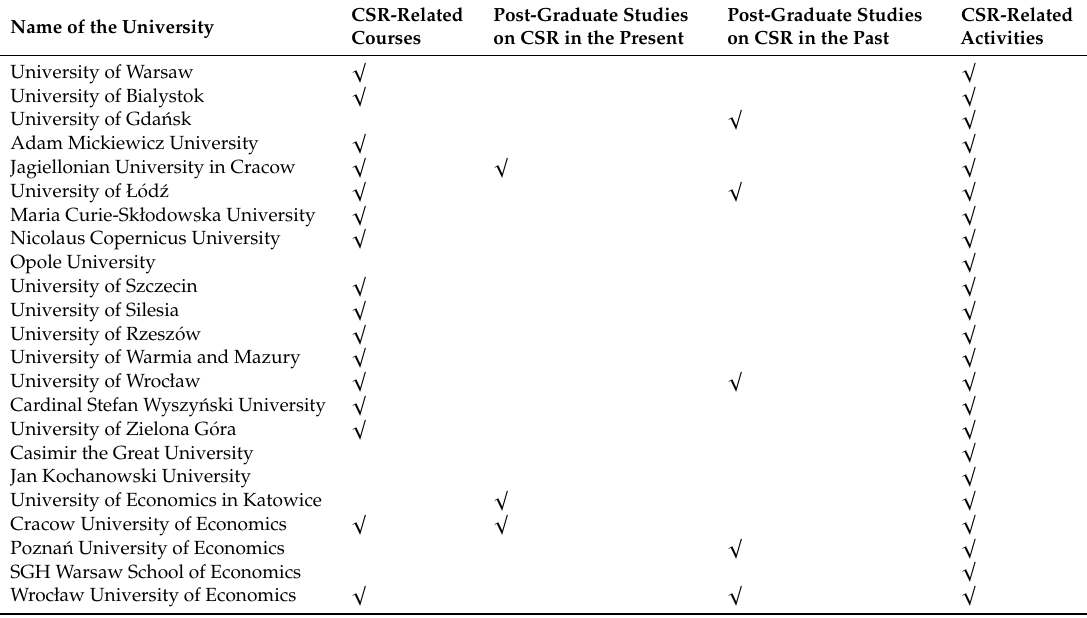
Table 1. Formal educational o ff ers on sustainable development and CSR at Polish